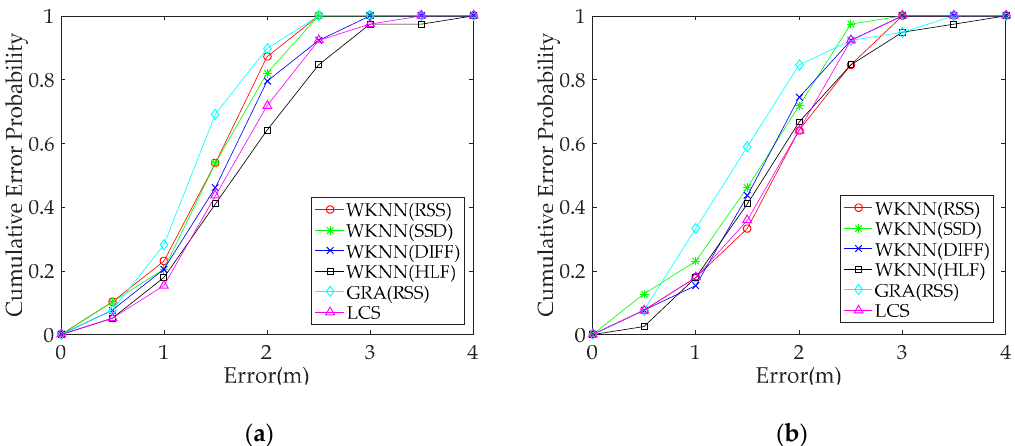
Figure 10. Comparison of positioning performance for different methods under heterogeneous and the same smartphones: The cumulative error probability represents the cumulative probability of absolute error of each TP. Fingerprint data are collected with the Redmi 5plus smartphone in the offline phase, and the test data are collected with different smartphones in the online phase: ( a ) Redmi 5plus and ( b ) Honor 9. Table 5. Detailed positioning errors for different methods under heterogeneous and the same smartphones.